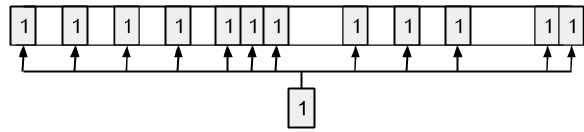
Figure 5. Mutation operation applied by the EA of